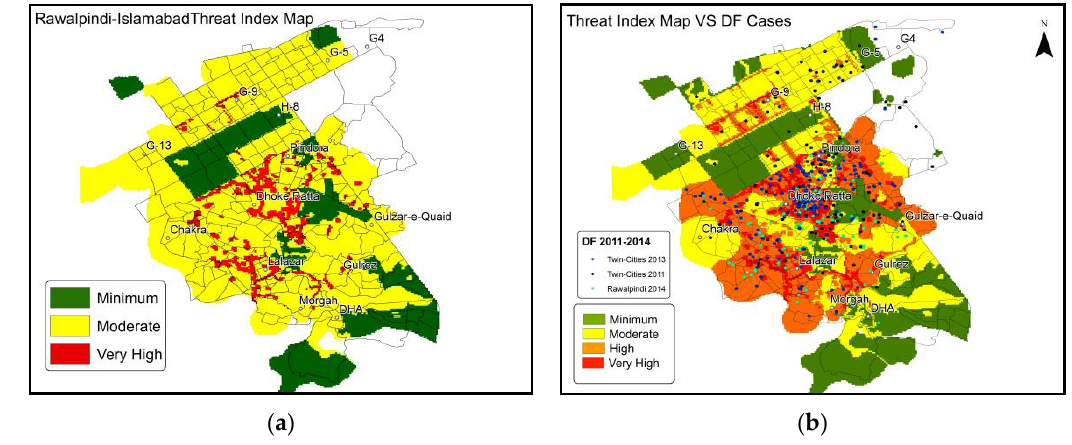
Figure 9. Threat Index Map (TIM): ( a ) Weight Overlay; ( b ) Weighted Sum vs. DF cases data.